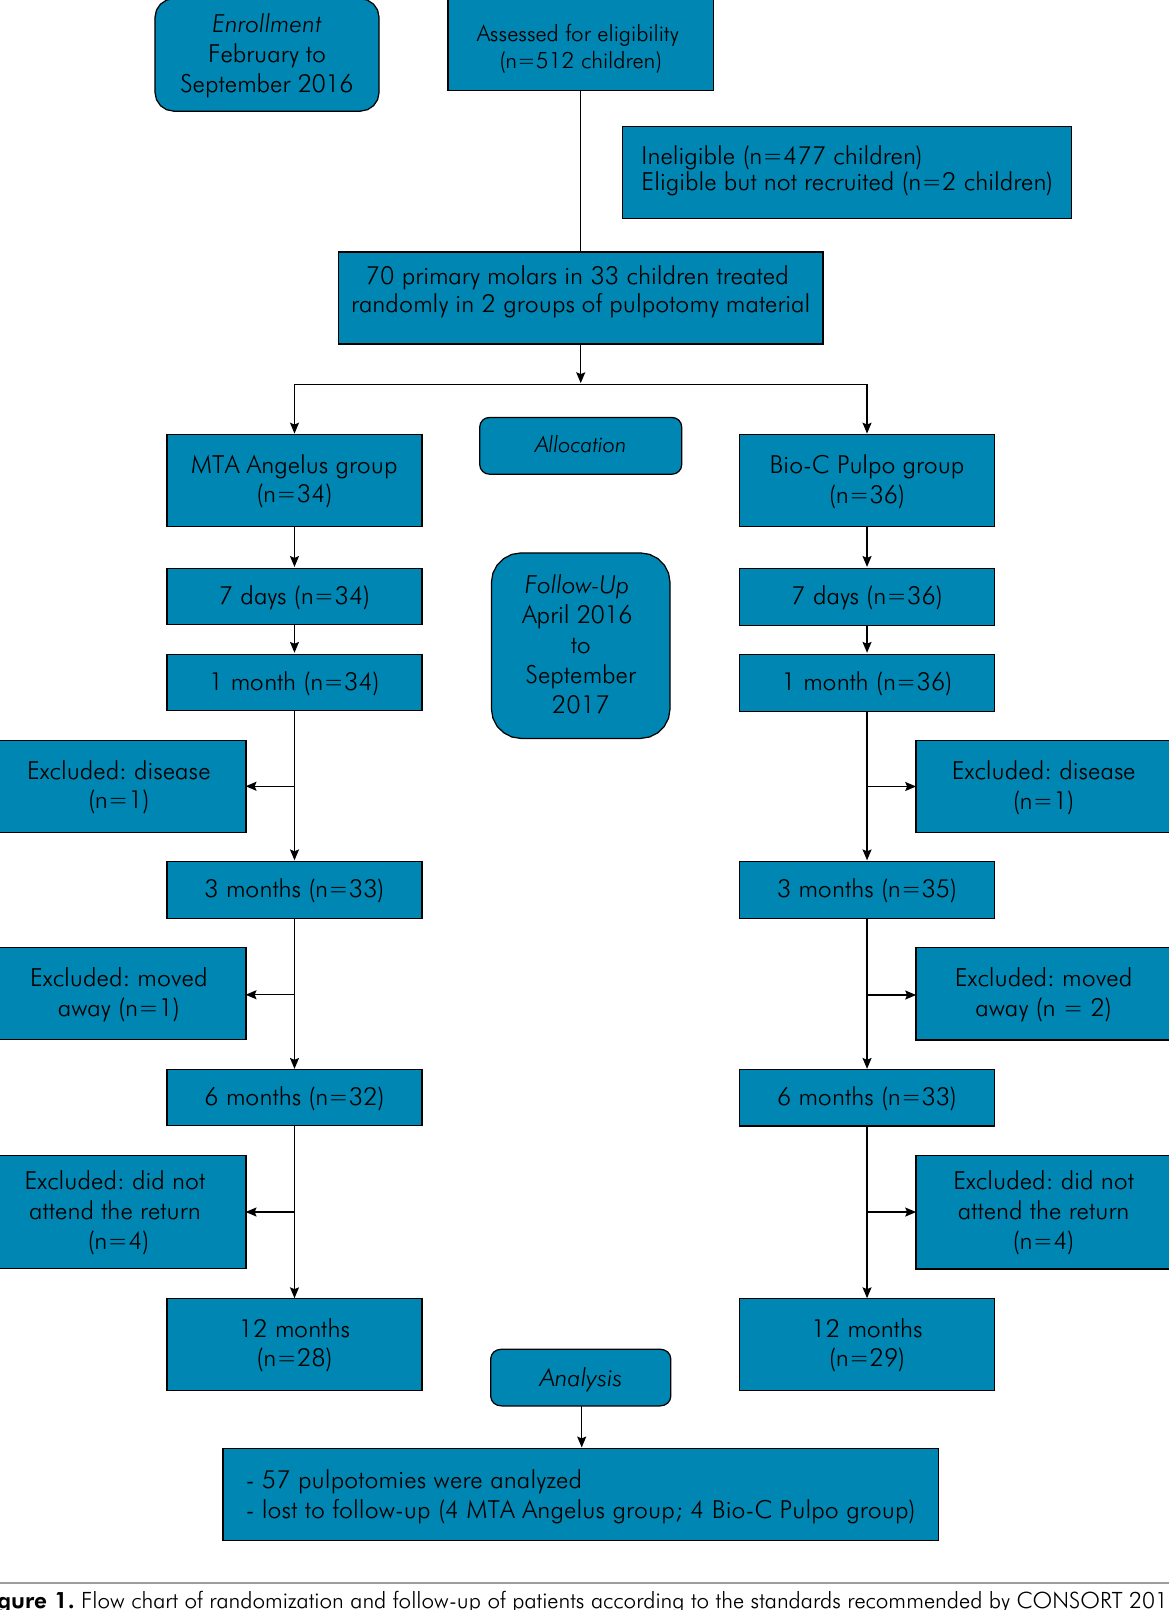
Figure 1. Flow chart of randomization and follow-up of patients according to the standards recommended by CONSORT